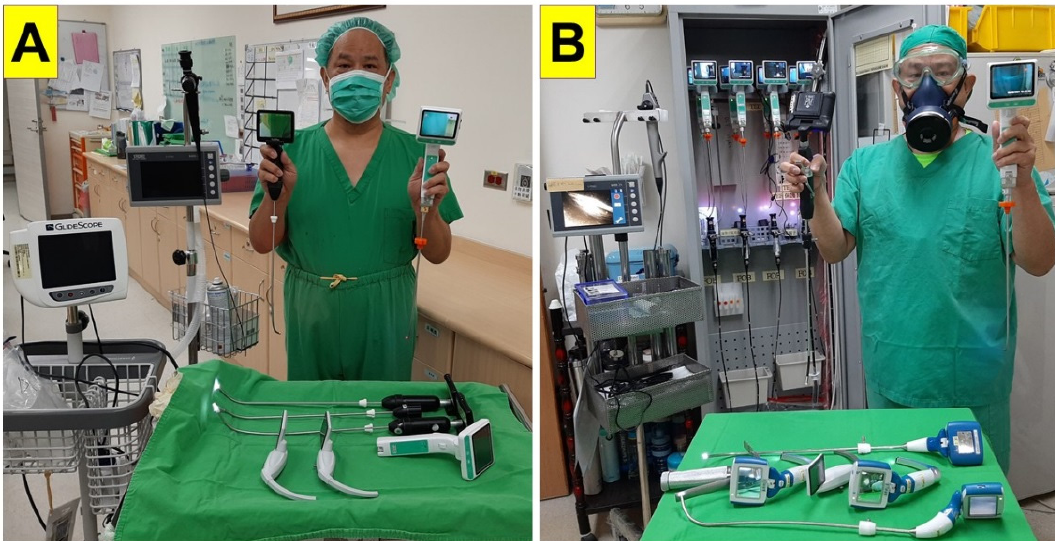
Figure 5. Prevalence of using video intubating stylet technique for tracheal intubation in Taiwan. ( A ) Department of An- esthesia in a 729-bed community hospital; ( B ) Department of Anesthesia in a 1110-bed tertiary medical Center.